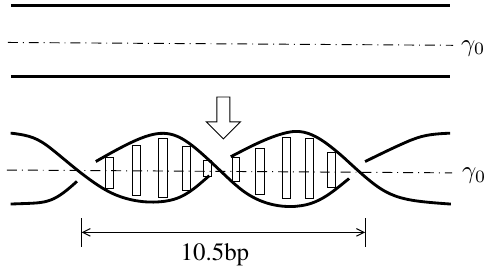
Fig. 1. The DNA double helix is modeled by a long thin strip.